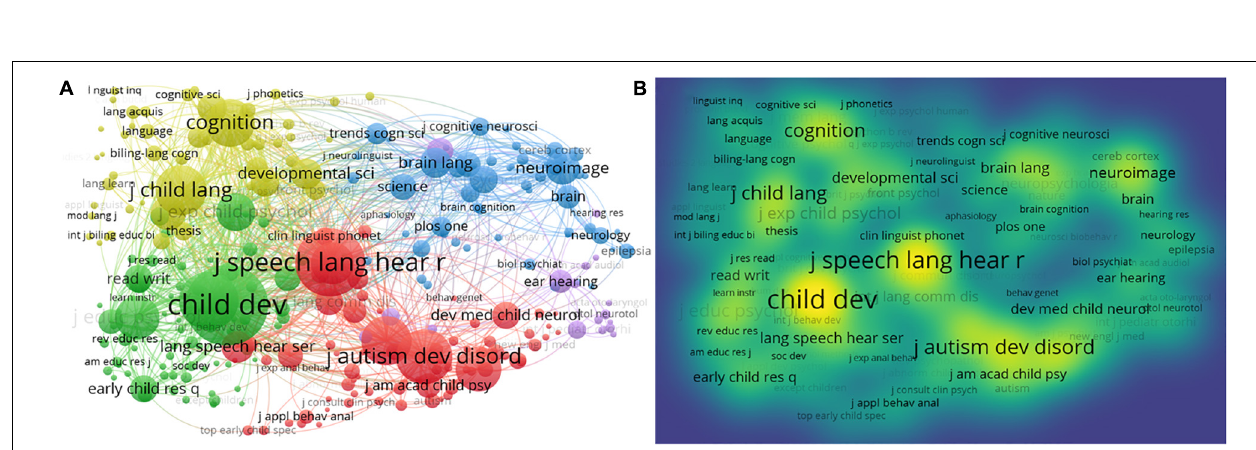
Frontiers in Psychology |